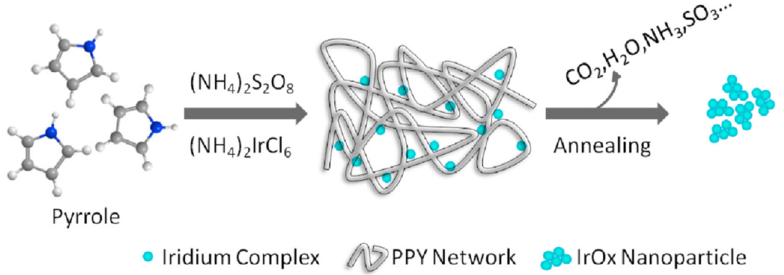
Figure 4. A schematic representation of the soft-template route for the synthesis of Iridium Oxide nanoparticles (Reprinted/adapted with permission from Ref. [99]).